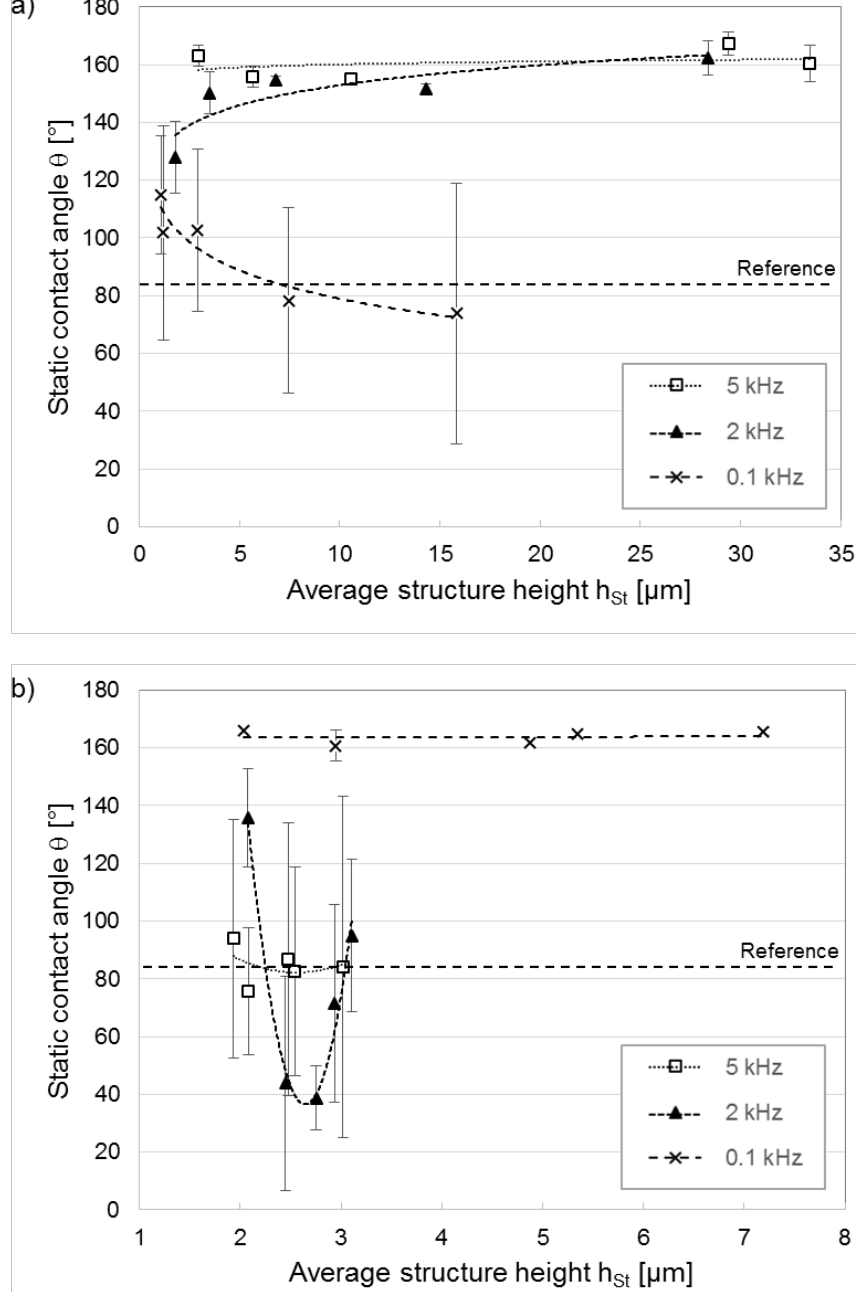
Figure 7. Static water contact angles as a function of structure depth and different process pulse repetition rates for ( a ) Λ = 19.0 µm and ( b ) Λ = 8.0 µm.